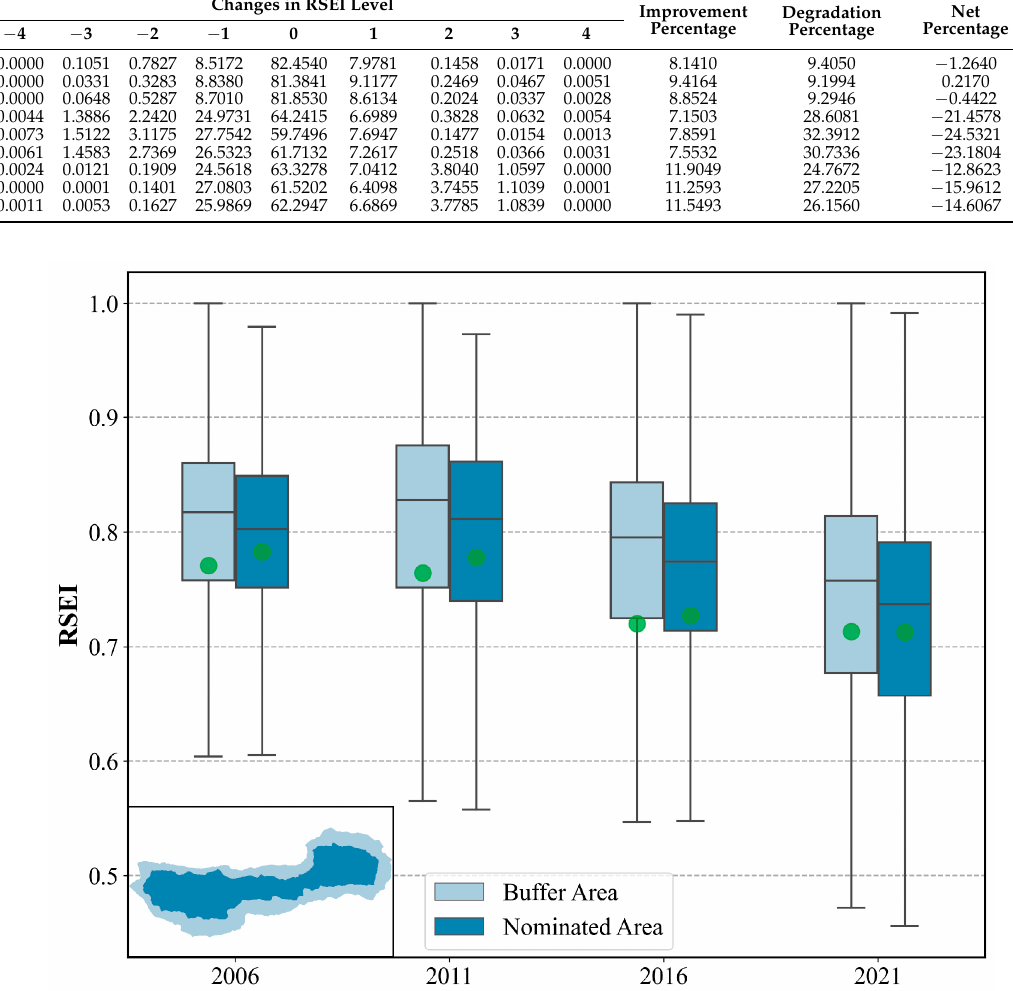
Figure 9. RSEI boxplot of bu ff er zone and nominated area from 2006 to 2021.